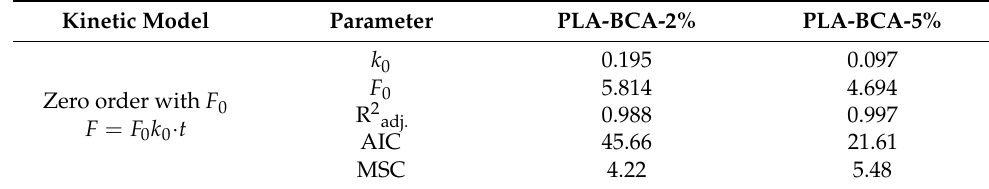
Table 6. Parameter values obtained for zero-order with F 0 kinetic model.